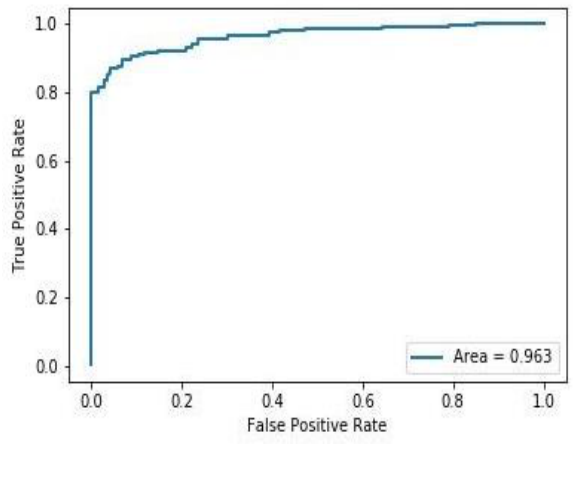
Figure 3. The graph of AUC-ROC recognition of melanoma-nevus for an ensemble of